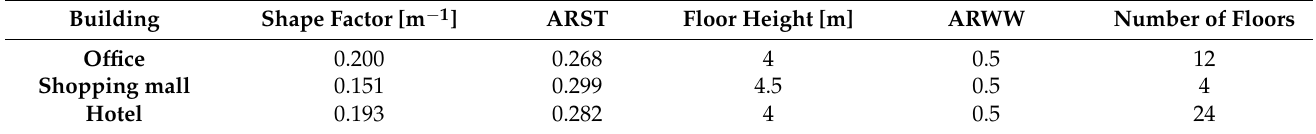
Table 7. Settings of other parameters for load prediction.